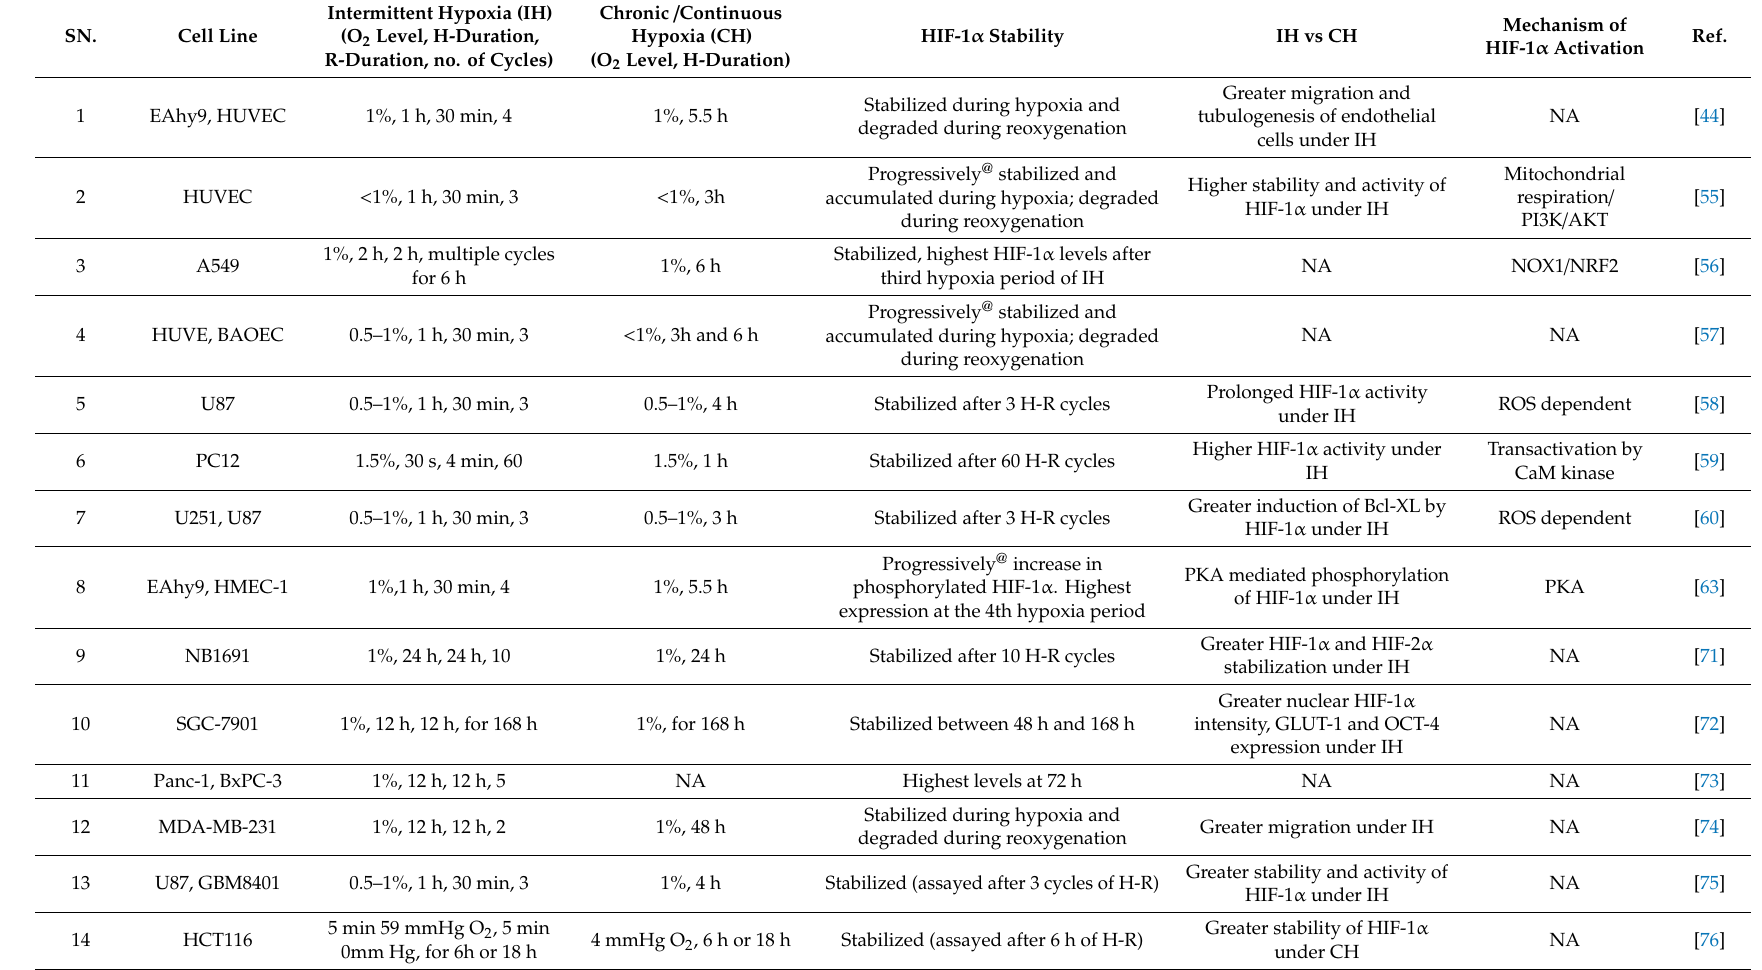
Table 2. HIF-1 α stability and activity under intermittent hypoxia in in vitro